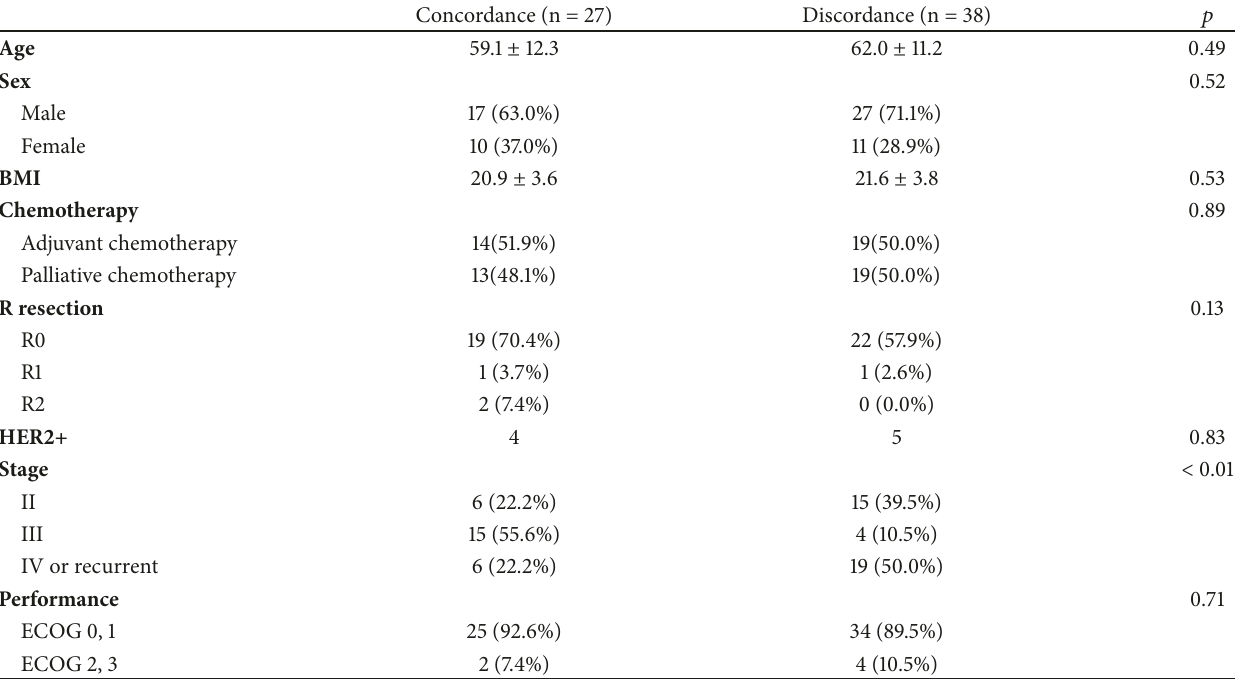
Table 2: Univariate analysis of the concordance rate between WFO and the GMDT.